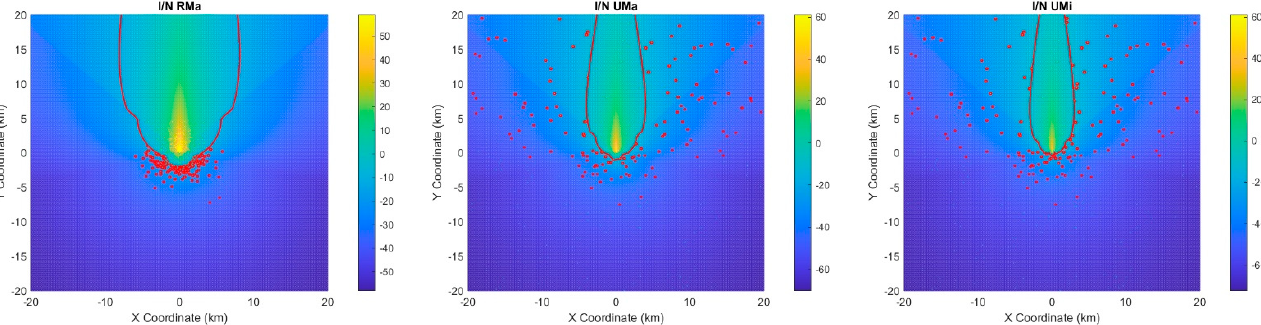
Figure 16. RMa, UMa, and UMi scenarios with ES antenna elevation angle of 5° for a 16 × 16 beamforming antenna array.